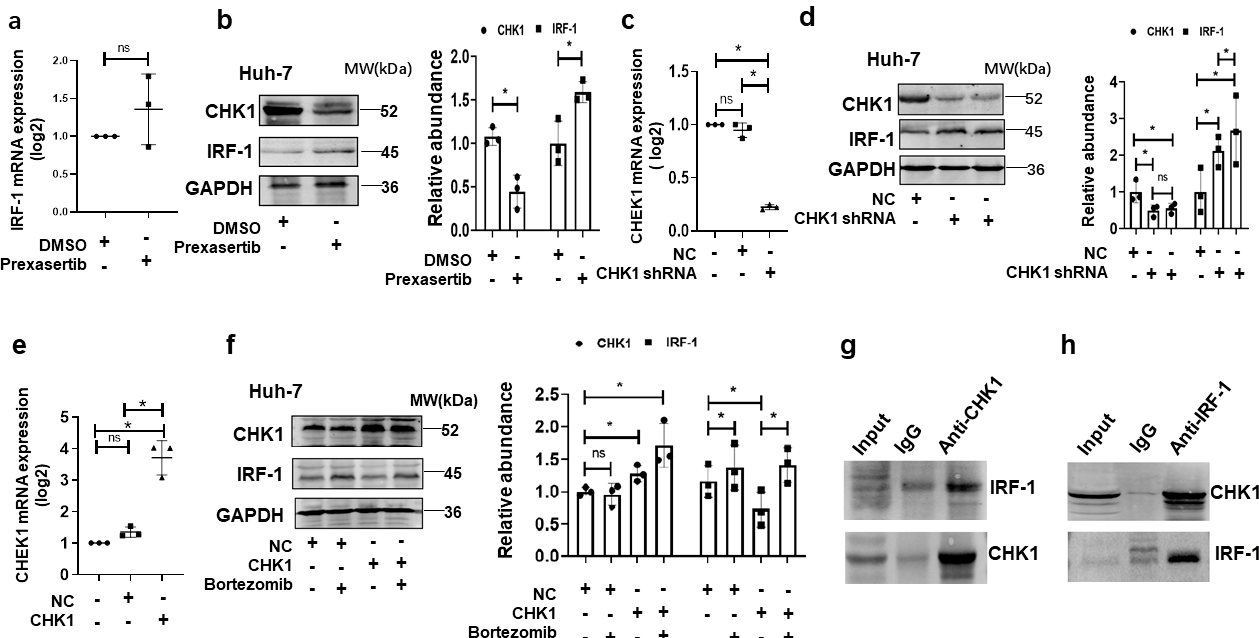
Figure 3. CHK1 exerts proteolytic effects on IRF1. ( a ) IRF1 mRNA expression is detected by qPCR in Huh-7 cells treated with prexasertib with a dose of 5 μ M for 24 h. ( b ) The whole lysate for IRF1 and CHK1 protein expression are measured by western blot in Huh-7 cells induced by prexasertib. The quantitative analyses for CHK1 and IRF1 are shown on the right. ( c ) CHEK1 mRNA expression is measured by qPCR in Huh-7 cells infected by lentiviral CHK1 shRNA or empty vector (NC) at a dose of 50 MOI for 48 h. ( d ) CHK1 and IRF1 proteins are detected by western blot in Huh-7 cells infected by lentiviral CHK1 shRNA or empty vector (NC). ( e ) IRF1 mRNA expression is measured by qPCR in Huh-7 cells infected by lentiviral CHK1 cDNA or empty vector (NC) at a dose of 50 MOI for 48 h. ( f ) CHK1 and IRF1 protein expression are measured by western blot in Huh-7 cells induced by overexpressed CHK1 (CHK1) or negative control (NC). The decreased IRF1 protein level induced by overexpressed CHK1 is reversed by bortezomib with a dose of 250 nM for 24 h. ( g ) Co-IP assay of Huh-7 cells induced by cisplatin with a dose of 10 μ M for 24 h. The interaction of IRF1 with CHK1 is determined by pulling down with anti-CHK1 antibodies and western blot with anti-IRF1 antibodies. ( h ) Anti-IRF1 antibody and western blot with anti-CHK1 antibody shows IRF1 pulled down CHK1. Each point represents an independent experiment. Data represent mean ± SD, * p <0.05, ns not significant. Western blot image shown are representative of 3 experiments. The uncropped blots are shown in Supplementary Figure S1.